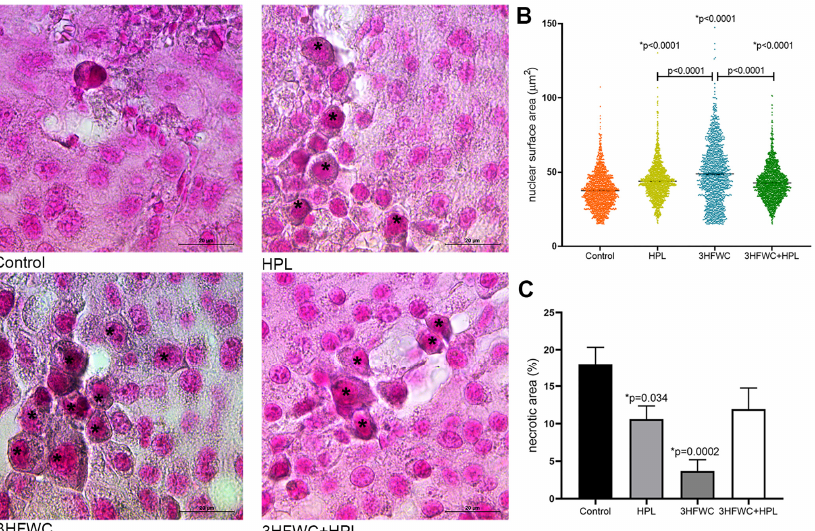
Figure 4. Histological signs of cellular senescence in melanoma in vivo induced by HPL, 3HFWC, or 3HFWC+HPL treatment. ( A ) Representative SBB-stained micrographs of melanoma tissue with lipofuscin-loaded cells (*) (scale bar and orig. magnification—20 μ m, × 100); ( B ) nuclear surface area of melanoma cells; ( C ) volume density of necrotic area in the tissue of untreated (control), HPL-, 3HFWC- and 3HFWC+HPL-treated animals, presented as mean ± SEM; statistical significance: in comparison to control (* p value) and between the treated groups. 3.1.4. Effects of 3HFWC and HPL on Melanoma-Associated Immune Cells In Vivo